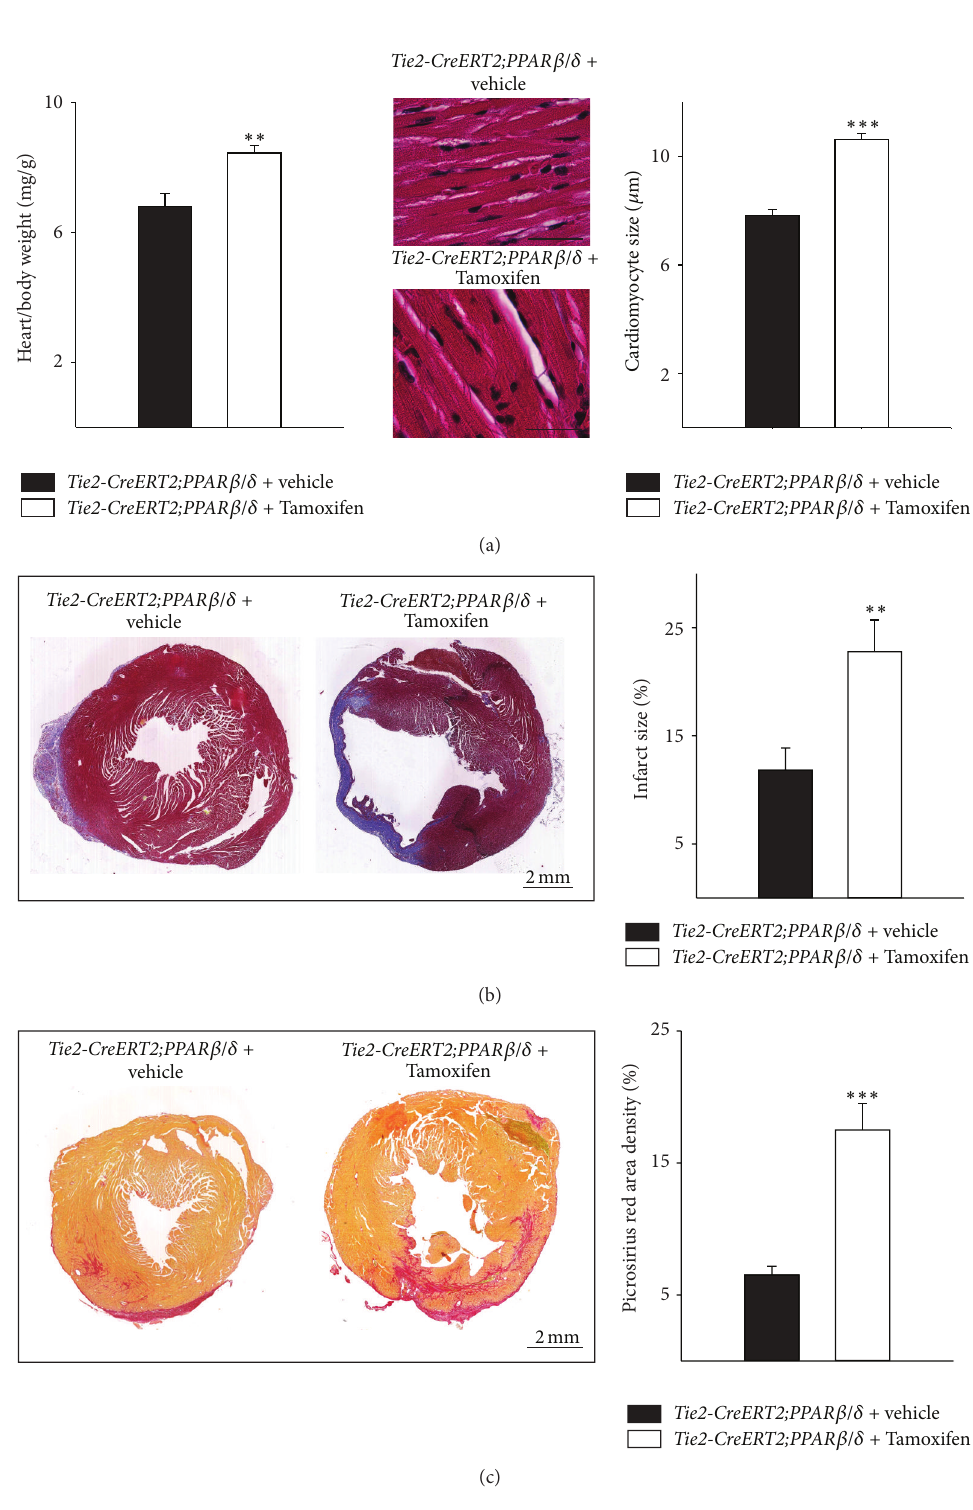
Figure 5: Increased infarct sizes and higher cardiac fibrosis in animals with vascular-specific PPAR 𝛽 / 𝛿 overexpression. (a) Respective heart- to-body weight ratios and high power photomicrographs of HE-stained heart sections showing individual cardiomyocytes and quantification of cardiomyocyte diameters. Scale bars indicate 50 𝜇 m. (b) Photomicrographs of Trichrome Masson stained cross sections and quantification of the infarct sizes ( Tie2-CreERT2;PPAR 𝛽 / 𝛿 + Tamoxifen, 𝑛 = 8 , and Tie2-CreERT2;PPAR 𝛽 / 𝛿 + vehicle, 𝑛 = 5 ). Scale bars indicate 2mm. (c) Photomicrographs of Picrosirius red stained cross sections and quantification of cardiac fibrosis. Scale bars indicate 2 mm. Data are means ± SEM. ∗∗ 𝑝 < 0.01 and ∗∗∗ 𝑝 < 0.001